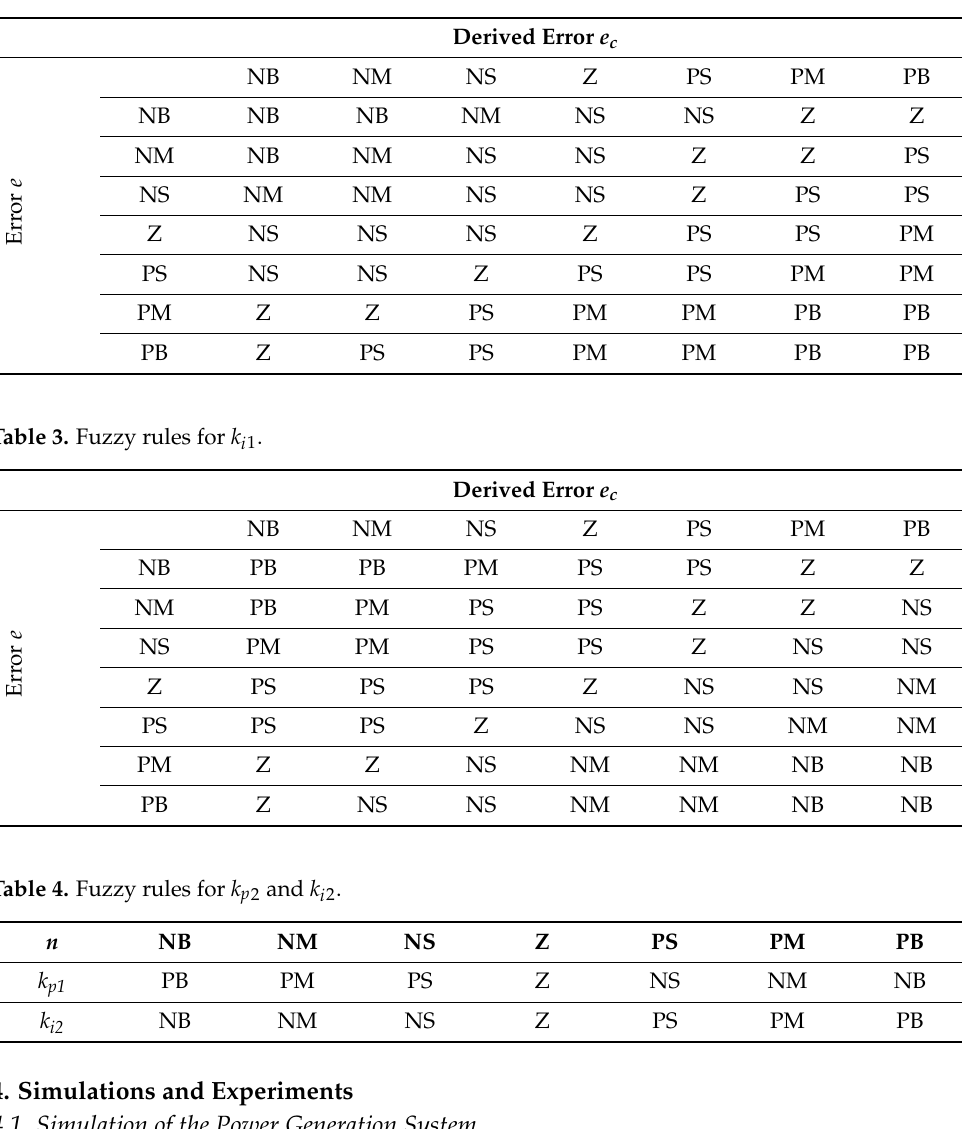
Table 2. Fuzzy rules for k p 1 .